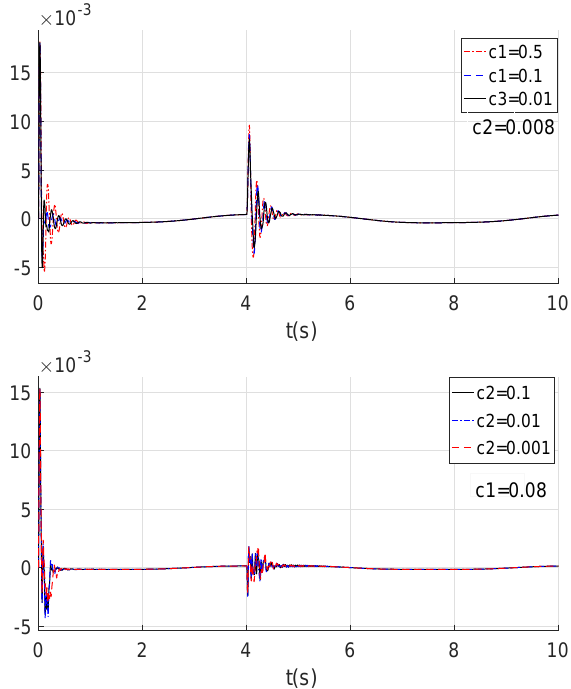
Figure 11. Curve with tracking error of hybrid control under the different parameters.